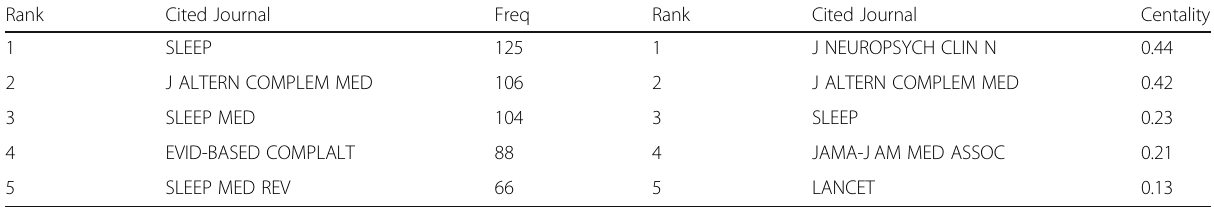
Table 2 Top 5 cited Journal related to acupuncture for insomnia